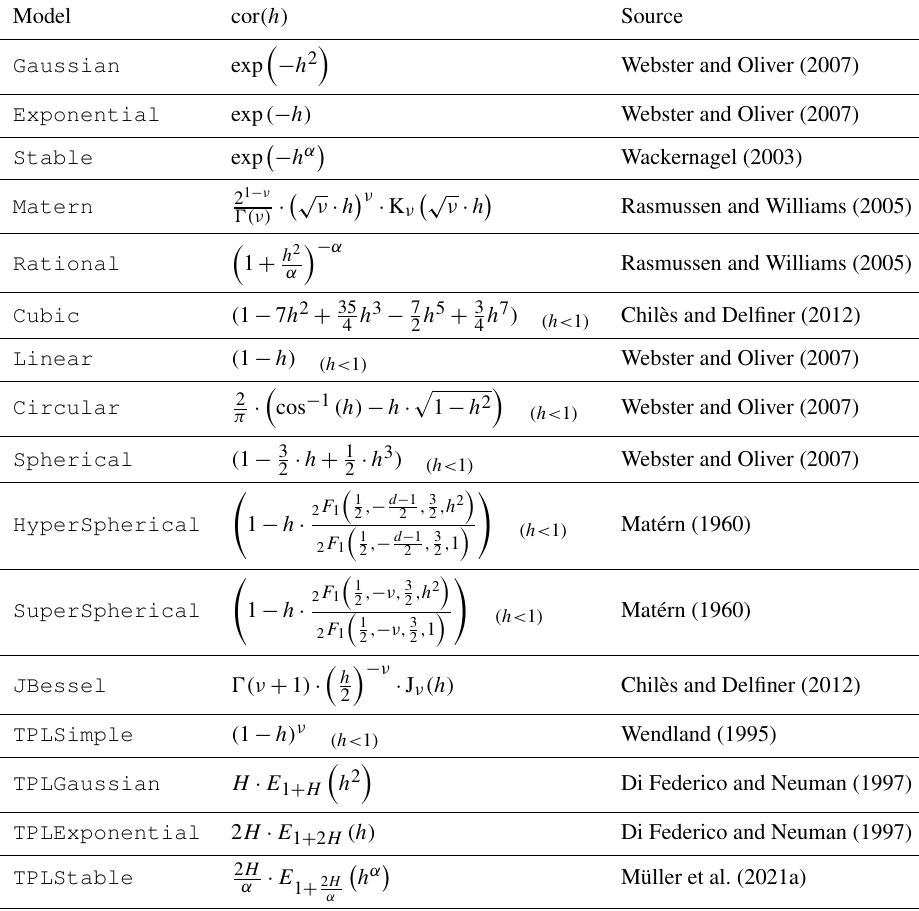
Table 1. Predefined covariance models in GSTools